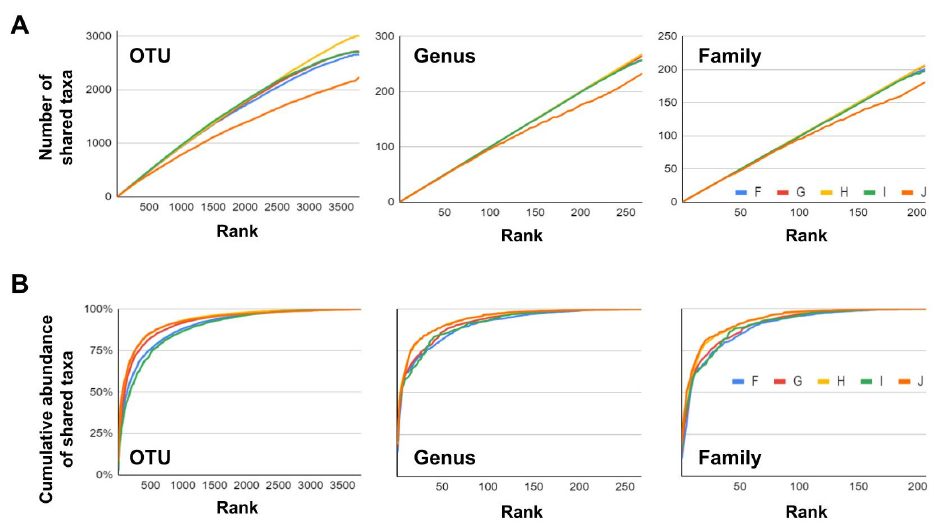
Figure 3. Comparison of bacterial taxa among plots within the YYL watershed. Bacterial taxa (OTUs, genera, families) were ranked by their mean relative abundance among samples from F, G, H, and I plots. ( A ) Number of taxa seen in a given plot (number of shared taxa) along respective ranking order. ( B ) Cumulative relative abundance of these shared taxa along respective ranking order. J plot is located outside of this watershed and is presented here for comparison.